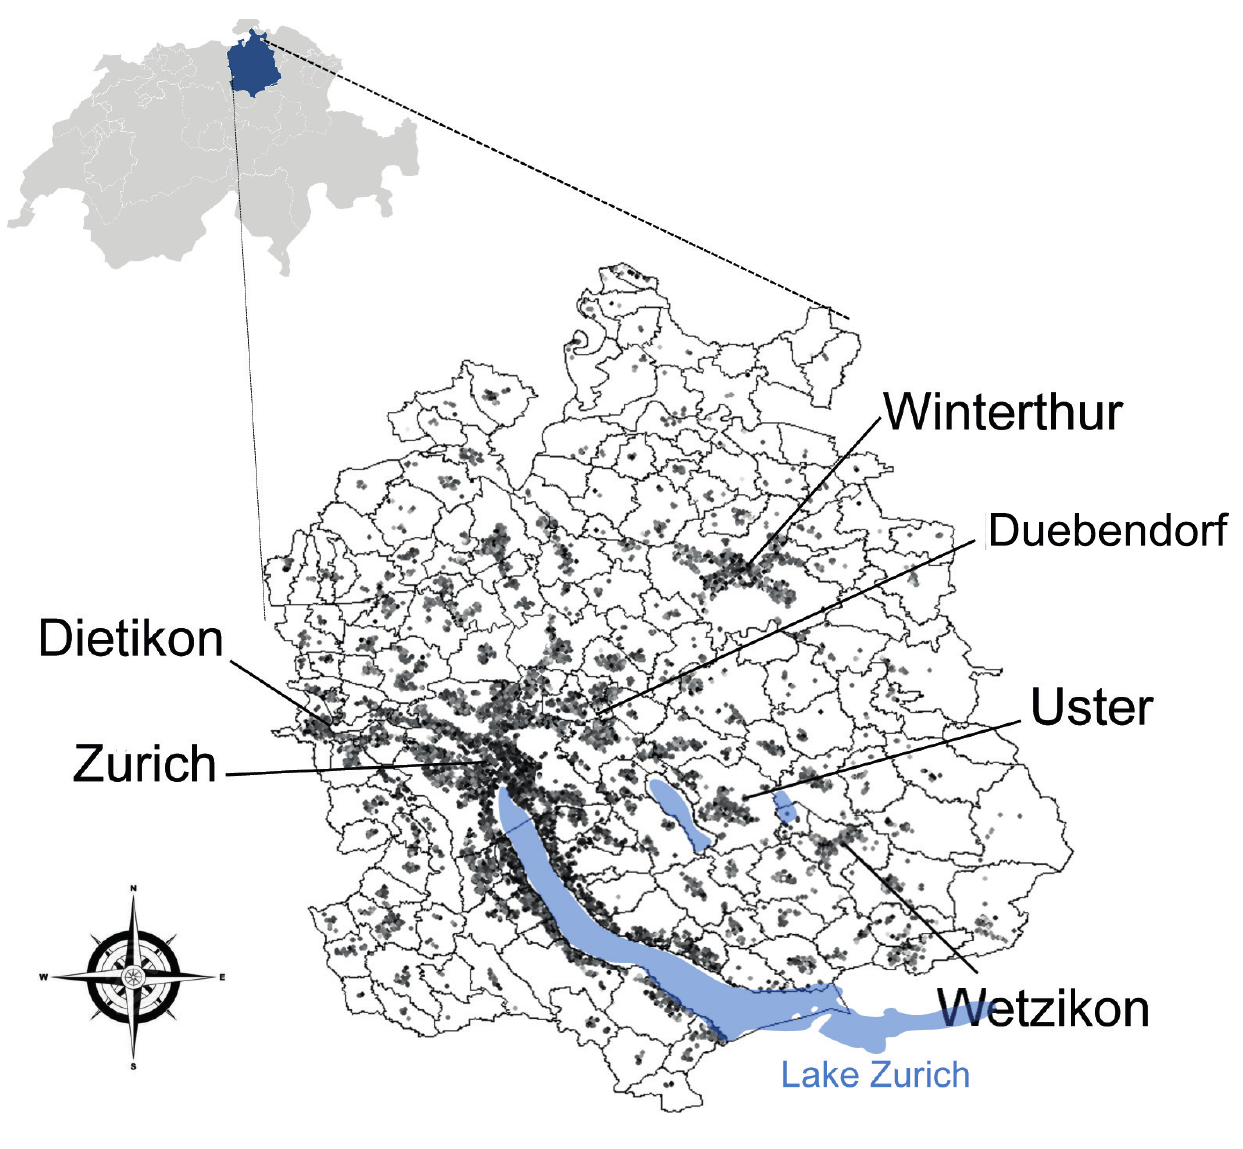
Figure 2. Map of the Canton of Zurich. (This figure shows the spatial dispersion of rental price observations in the canton of Zurich. The light- and dark-colored dots represent low and high rents in the data sample, respectively. The solid shapes of the map indicate the 171 communes within the canton’s boundaries. The dispersion of observations corresponds to the variation in residents, with 36% of the observations coming from Zurich (largest city) and Winterthur (second largest city). The total population of the canton of Zurich amounts to approximately 1.4 million at the end of